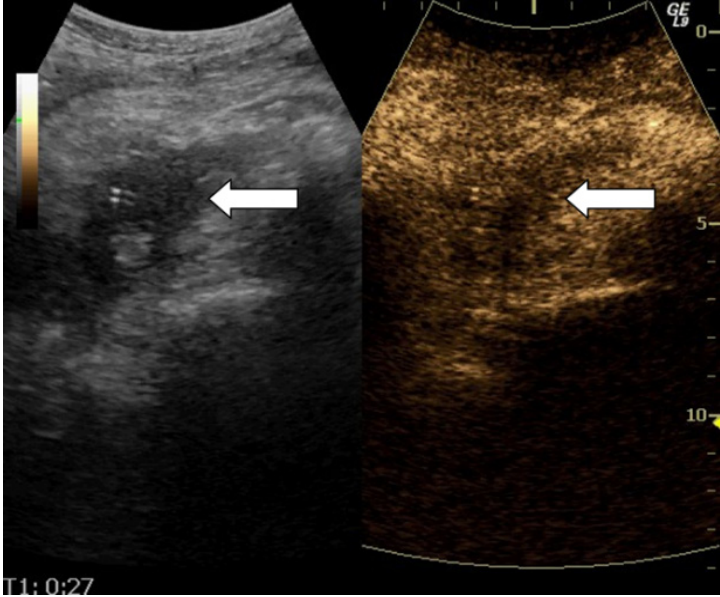
Figure 2. Dual scan image of a pancreatic lesion. B-mode image to the left and contrast image to the right. Observer A1 and B judged isoenhancement and observer A2 judged hypoenhancement. The histological diagnosis was